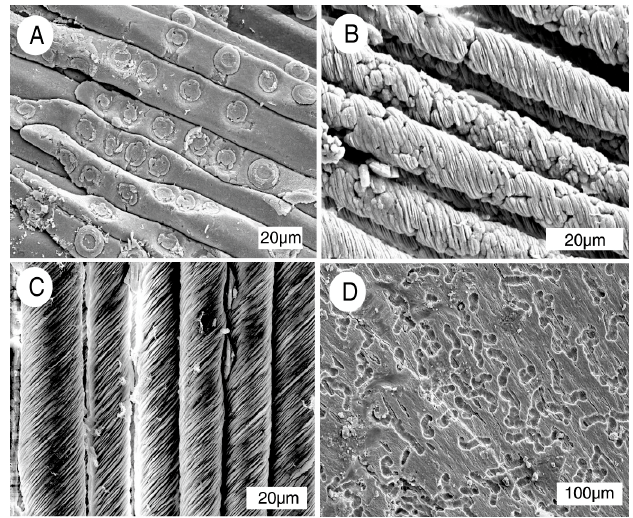
Figure 12. SEM images of Bruneau Woodpile specimens. ( A ) Conifer wood, radial orientation, showing tracheids with well-preserved bordered pits; ( B , C ) Radial view of specimens of reaction wood, where tracheids have spiral architecture in the secondary cell wall; ( D ) Exterior surface of this limb shows galleries produced in the mineralized wood by chemolithotrophic microbes (see text for discussion).